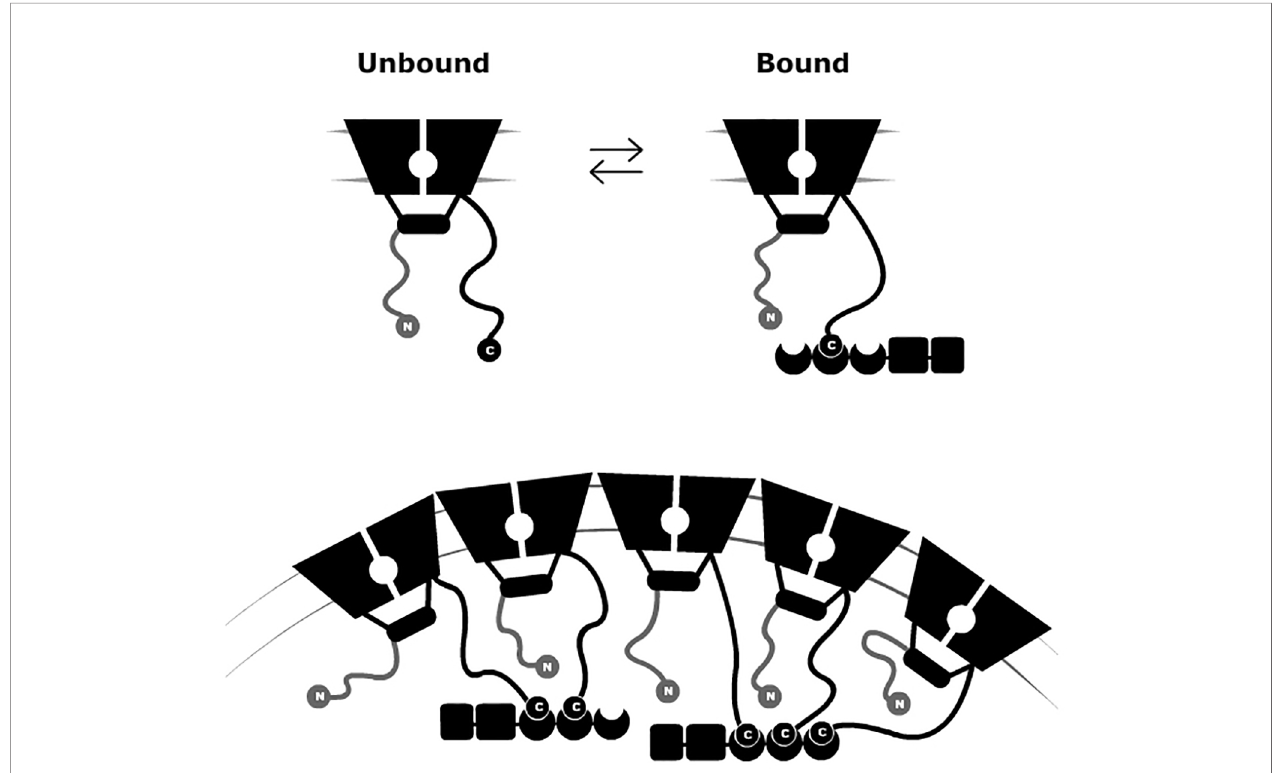
FIGURE 2 | A “ ball and chain ” mechanism for Kv channel clustering. Schematic representation of the “ ball and chain ” mechanism for channel binding to PSD-95 (upper panel). In the inter-molecular ‘ ball and chain ’ binding mechanism, the interaction of the Kv channel with the membrane-associated PSD-95 scaffold protein is precisely timed, as determined by C-terminal chain length, upon binding of the “ chain ” -tethered peptide “ ball ” to the PSD-95 PDZ domain(s). Given the stoichiometry of the interaction and the ability of PSD-95 to aggregate, channel clustering results (lower panel). The membrane-embedded portion corresponds to the channel voltage-sensor and pore domains, while the rectangular shape corresponds to the T1 assembly domain. The crescent, box, and rectangular shapes represent the PDZ, SH3, and guanylate kinase-like domains of the PSD-95 protein, respectively. PSD, post-synaptic